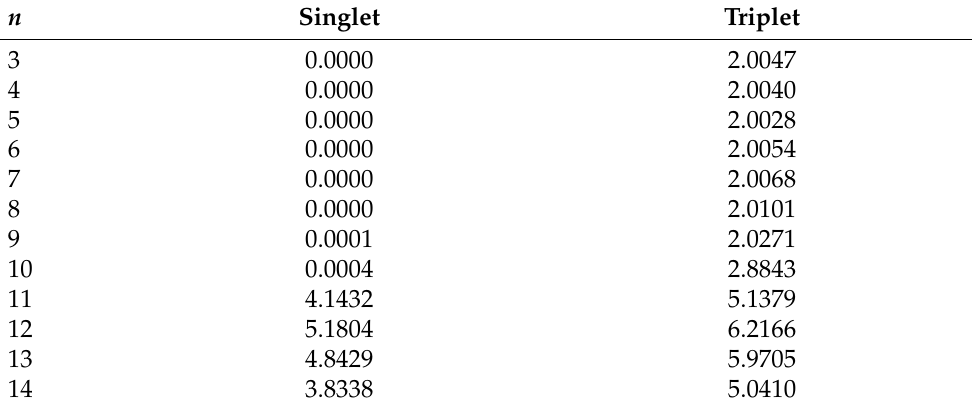
Table 1. Expectation values of the total spin-squared operator (cid:104) ˆ S 2 (cid:105) associated with the lowest singlet and lowest triplet states of n -HGQR, calculated by spin-unrestricted KS-LDA. For the exact theory, the value of (cid:104) ˆ S 2 (cid:105) should be 0 for the lowest singlet state and two for the lowest triplet state. n Singlet